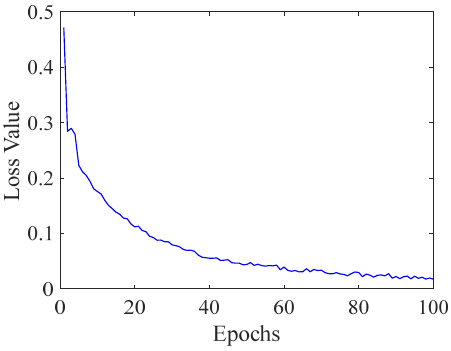
Figure 16. Loss function curve.